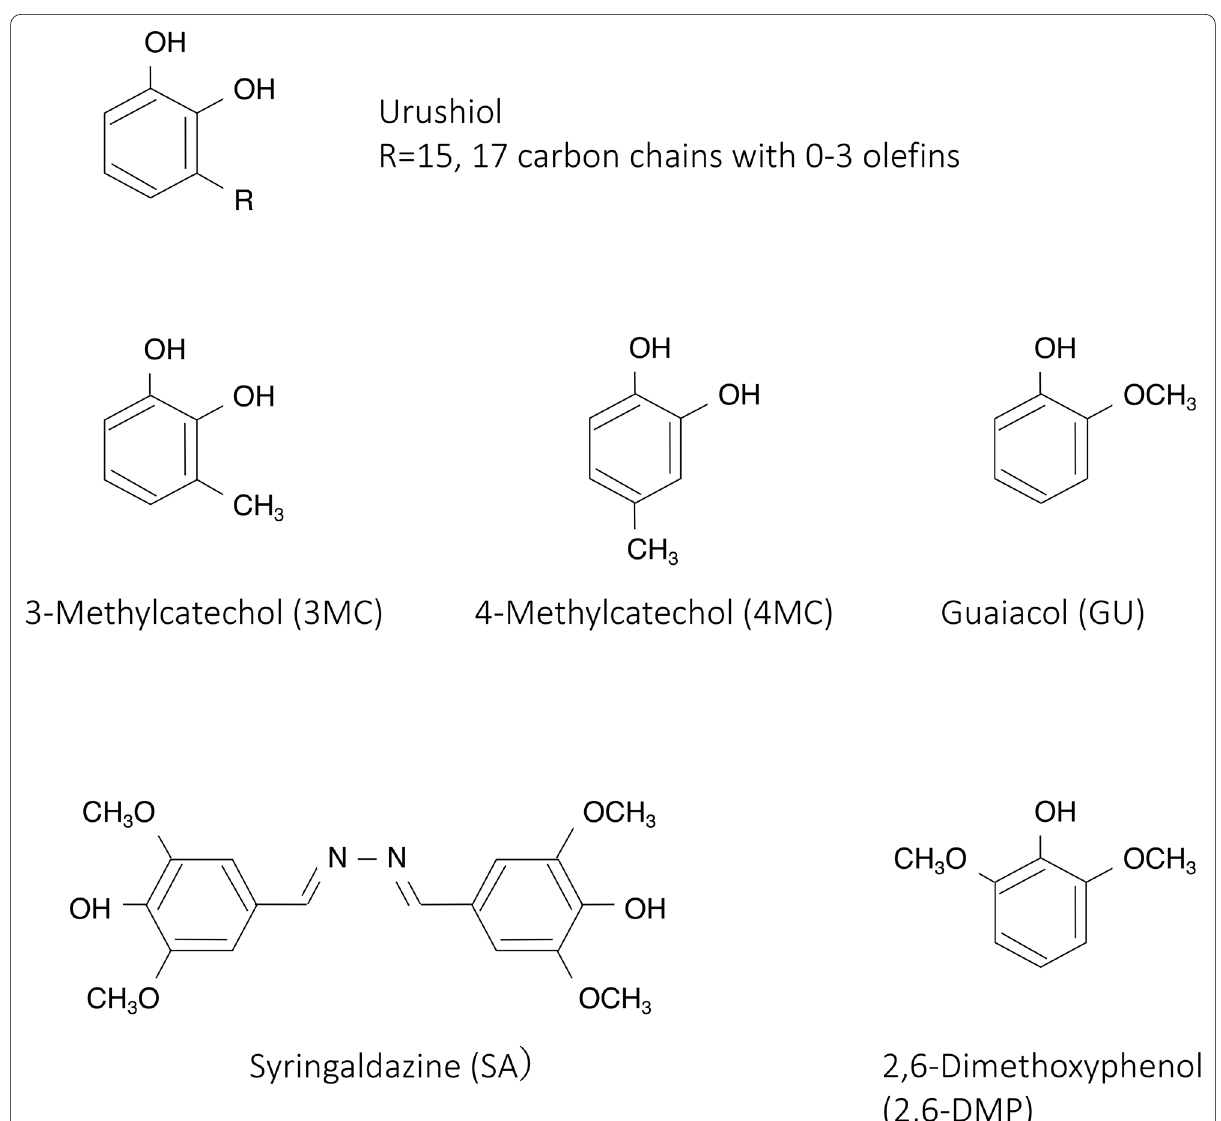
Fig. 8 Chemical structures of urushiol and substrates used for laccase activity measurement in this